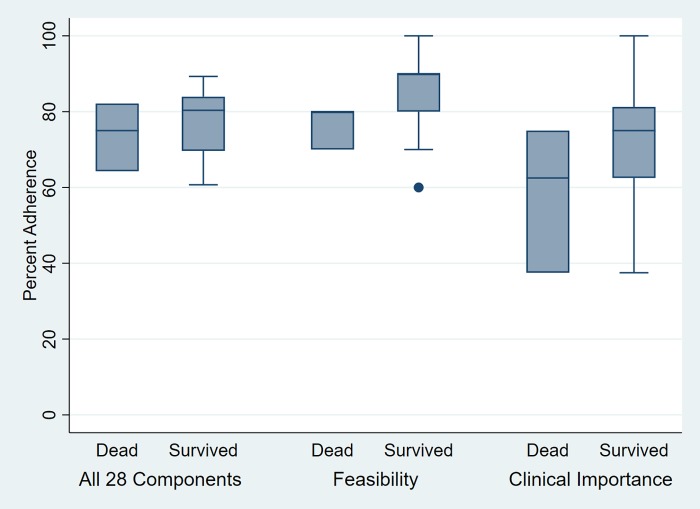
Percent Adherence across various criteria, comparing between dead and survived cases.